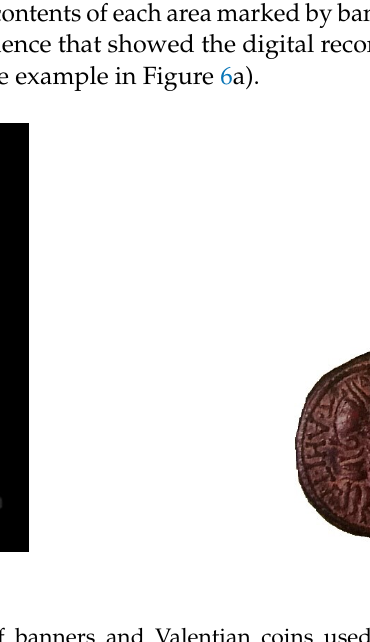
Figure 6. Examples of banners and Valentian coins used in the interface. ( a ) Main banner. ( b ) Valentian